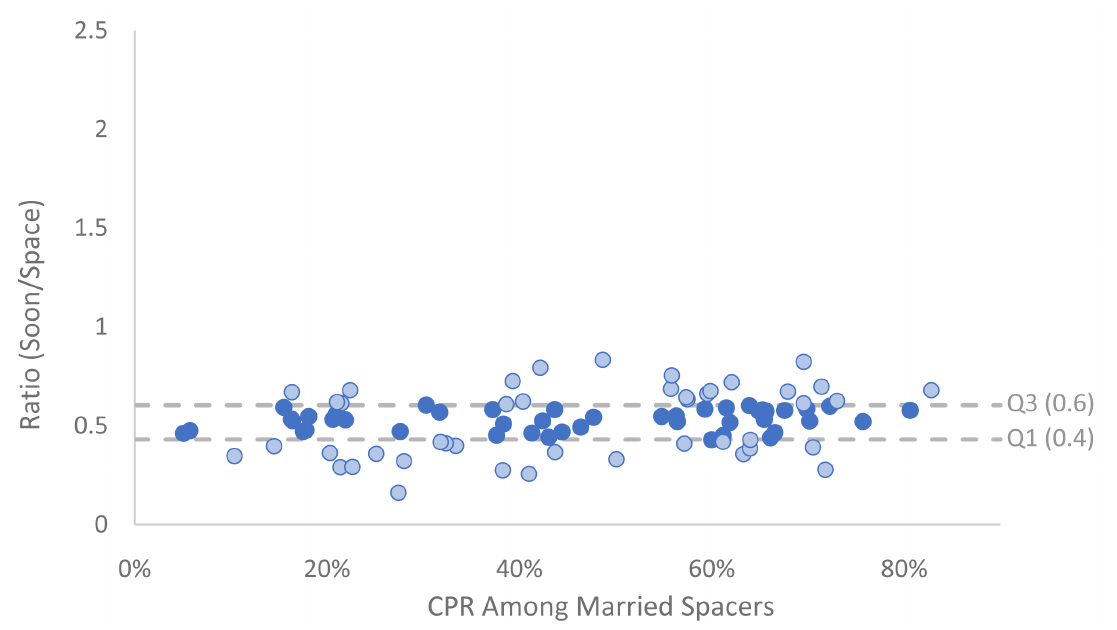
Figure 3. Ratio of married CPR: soon/space by CPR among married spaces. This graph shows data from recent surveys, showing the contraceptive prevalence rate (CPR) among married spacers compared to the ratio of CPR between women who want a child soon and those who wish to space. The dotted lines indicate the interquartile range (IQR). Light blue dots are outside of the range.